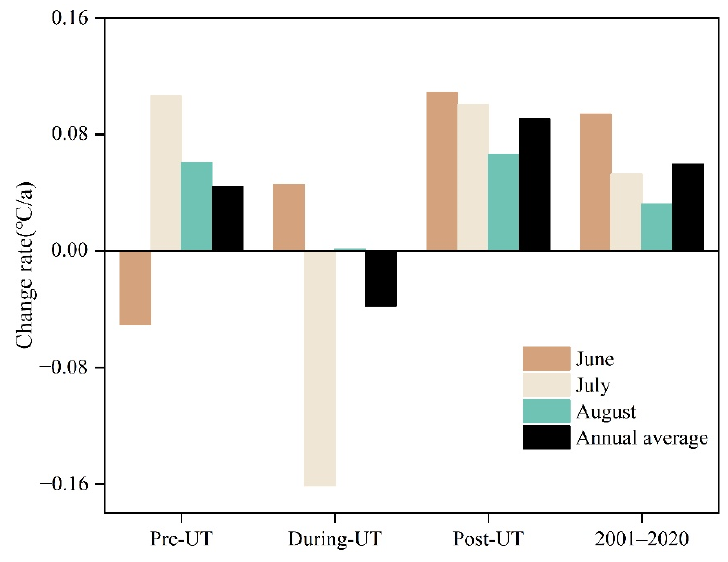
Figure 4. Average DI change rate in June, July, August, and year.